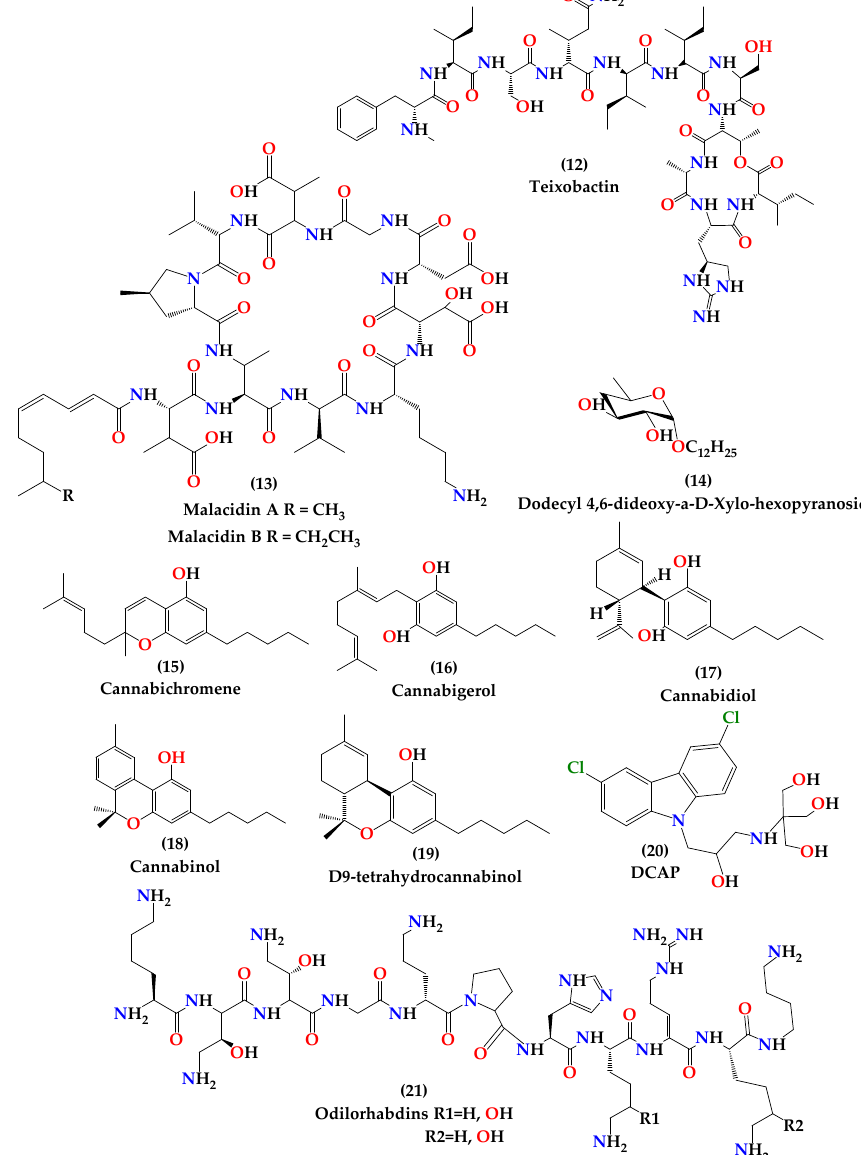
Figure 5. Chemical structures of teixobactin (12), malacidins (13), dodecyl Figure5. Chemicalstructuresofteixobactin(12),malacidins(13),dodecyl4,6-dideoxy- α -D-Xylo-hexopyranoside 4,6-dideoxy-α-D-Xylo-hexopyranoside (14), cannabichromene (15), cannabigerol (16), cannabidiol (14), cannabichromene (15), cannabigerol (16), cannabidiol (17), cannabinol (18), ∆ 9-tetrahydrocannabinol (19), (17), cannabinol (18), ∆9-tetrahydrocannabinol (19), DCAP (20), and Odilorhabdins (21). DCAP (20), and Odilorhabdins